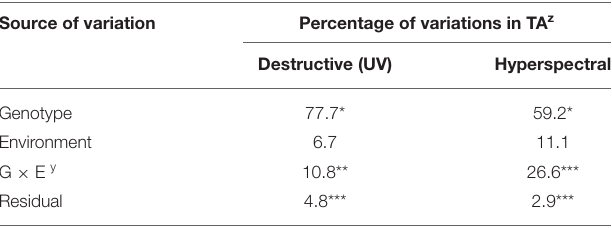
TABLE 2 | Percentages of variations in anthocyanin accumulations (mg/g) associated with genotype, environment, and genotype by environment interaction for the leaves of four bok choy genotypes grown in different environmental conditions (NC and SC) with different growth stages (GS1 and